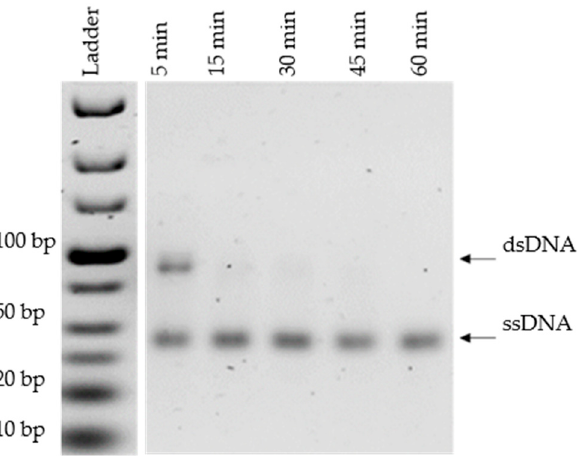
Figure 5. Agarose gel electrophoresis (4% agarose, 90 V, 2 h in TAE 1 × GelRed ® ) of the final products after 5 to 60 min of incubation with lambda exonuclease. Products were revealed on a 4% agarose gel at 90 V for 2 h (TAE 1 × , GelRed ®